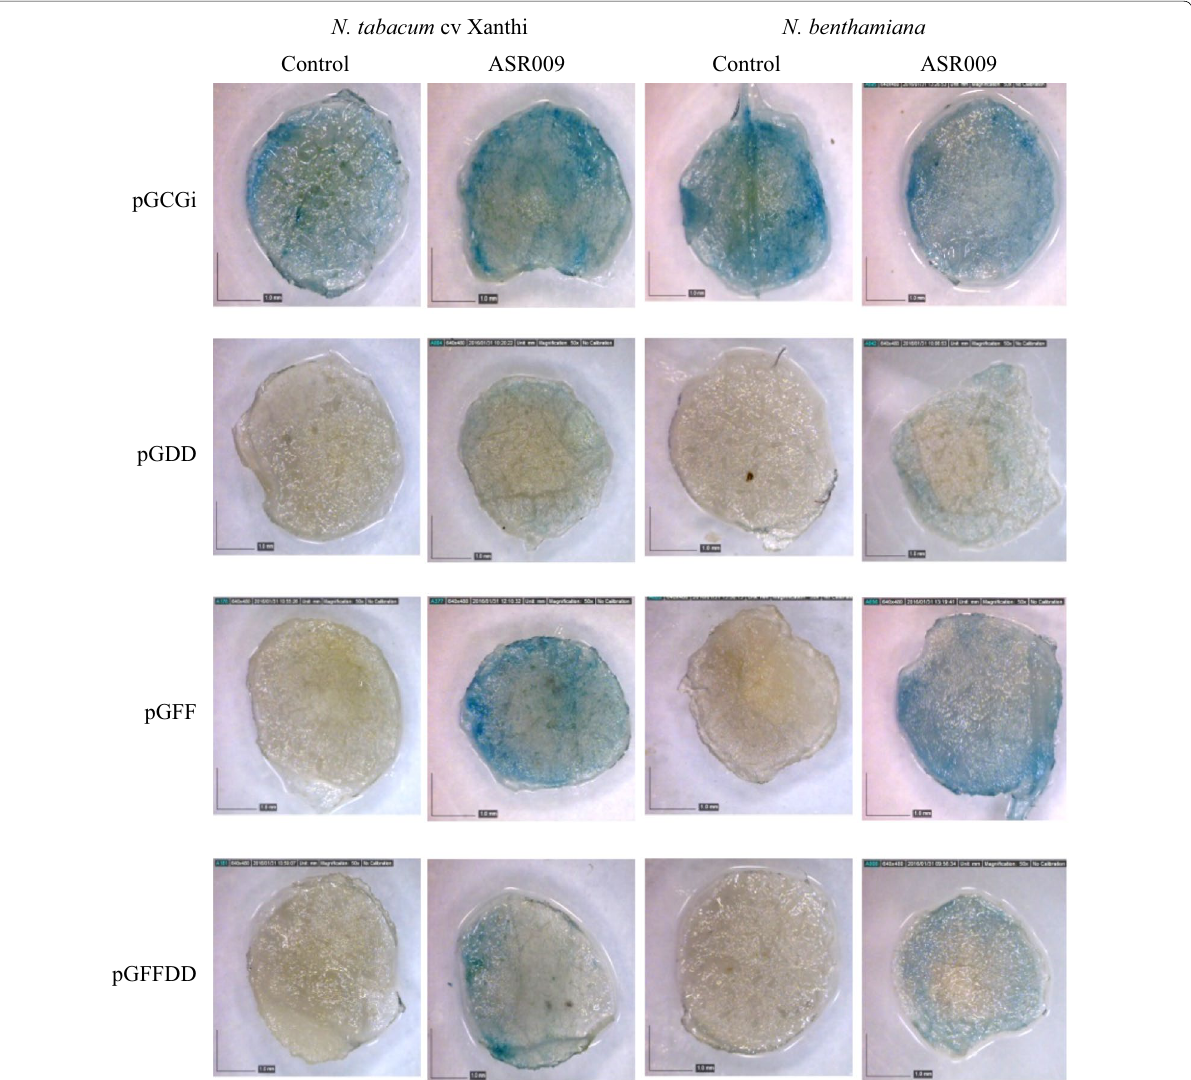
Fig. 6 Effect of Ascochyta rabiei pathotype ASR009 on pGCGi, pGDD, pGFF and pGFFDD constructs evaluated on two tobacco species; N. tabacum cv. Xanthi and N. benthamiana . Agro-injected plants without treatment by fungal elicitor used as control (More replications have been presented in Additional file 1: Fig. S3 attached to the